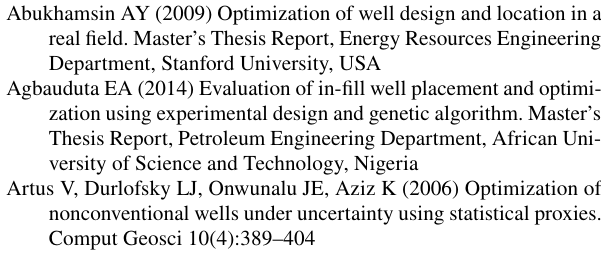
Fig. 22 A graph of probability versus NPV for P10, P50, and P90